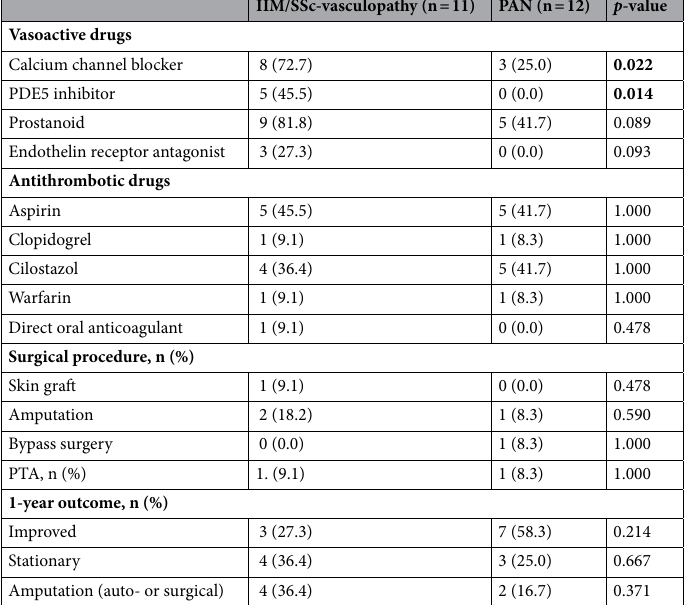
Table 4. Treatment and 1-year outcome of limb ischemia. Data are expressed as number (%) of patients. Significant values are in bold. IIM idiopathic inflammatory myopathies, PAN polyarteritis nodosa, PDE phosphodiesterase, PTA percutaneous transluminal angioplasty, SSc systemic